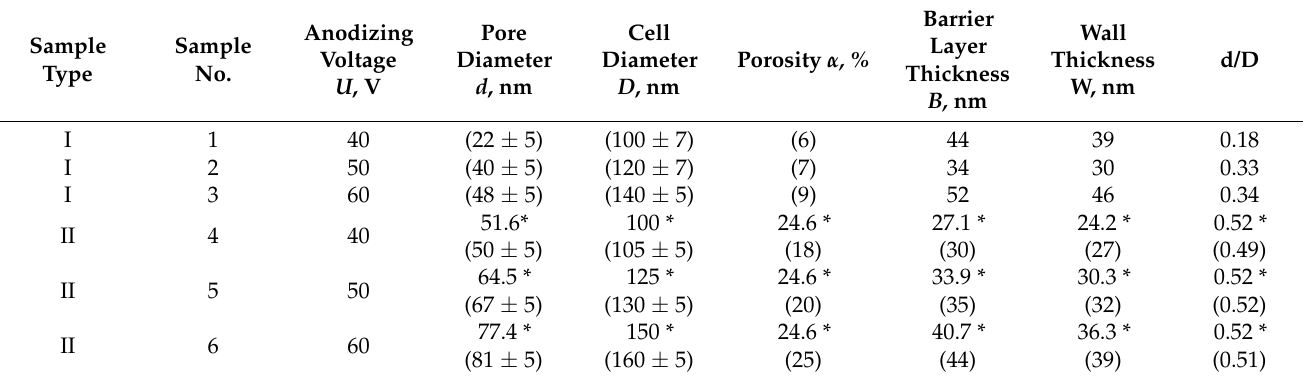
Table 1. The experimental samples’ primary morphological features (before etching, as-fabricated amorphous